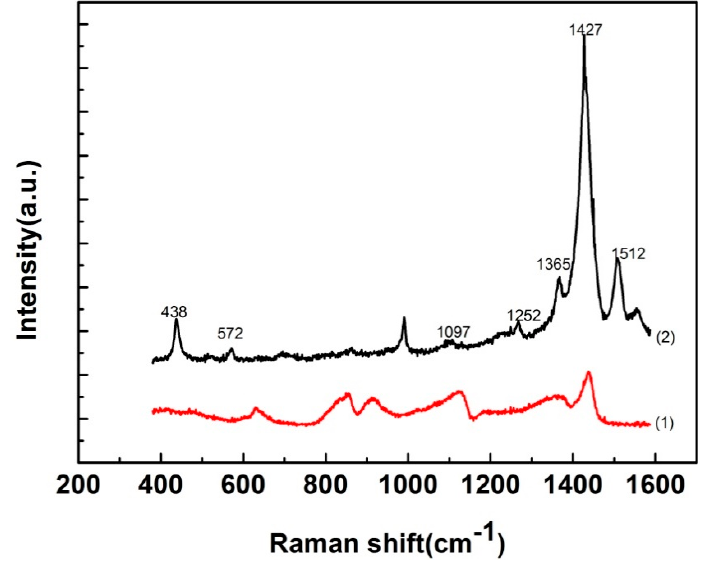
Figure 3. Raman spectra of the (1) electrospun pure PVA fibers, (2) PVA/PEDOT:PSS composite fibers.